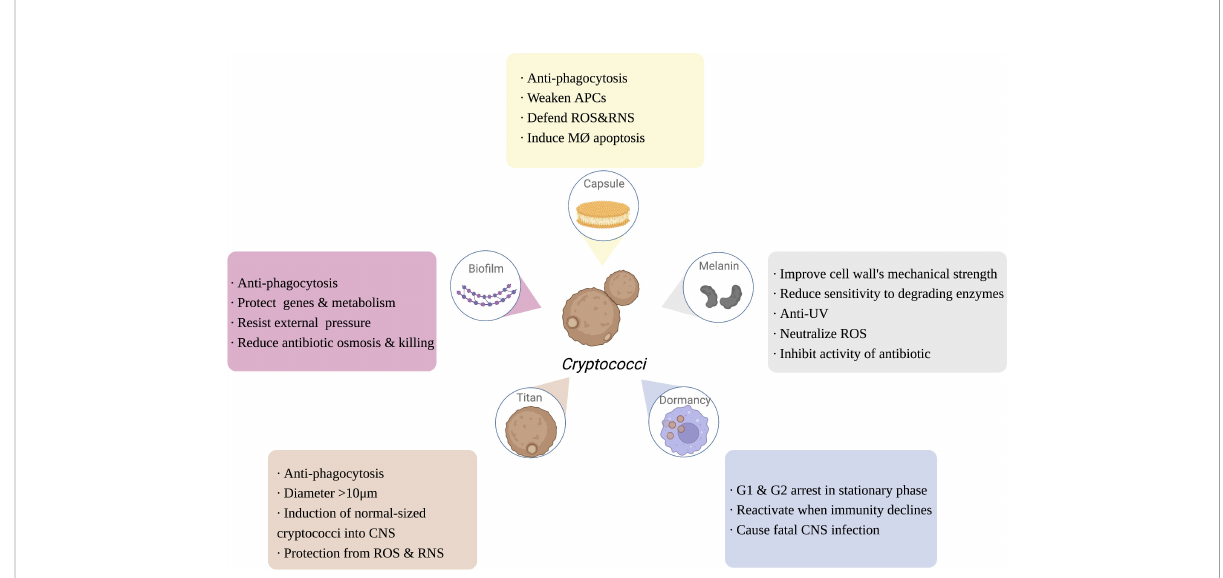
FIGURE 2 The function of Cryptococcus immune escaping. Capsule, melanin, dormancy, titan cells and bio fi lm of Cryptococcus are also involved in the process of escaping the host ’ s immunity, enhancing the ability of Cryptococcus to infect the host. APCs, antigen presenting cells; ROS, reactive oxygen species; RNS, reactive nitrogen species; MØ, macrophage; UV, ultra violet; CNS, central nervous system. Created in